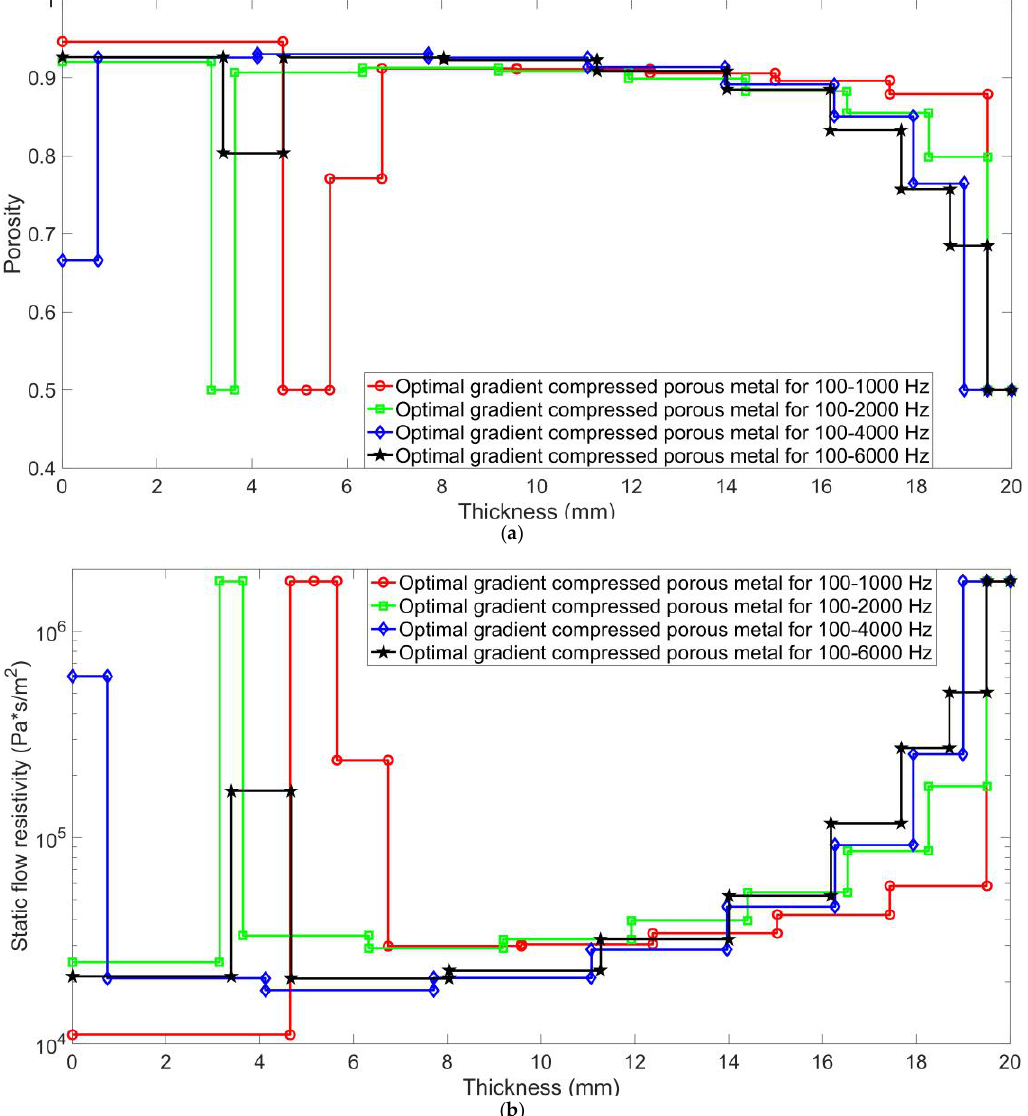
Figure 10. Distribution of structural parameters of the optimal 10-layer gradient compressed porous metals along the thickness direction. ( a ) Porosity; ( b ) static flow resistivity.